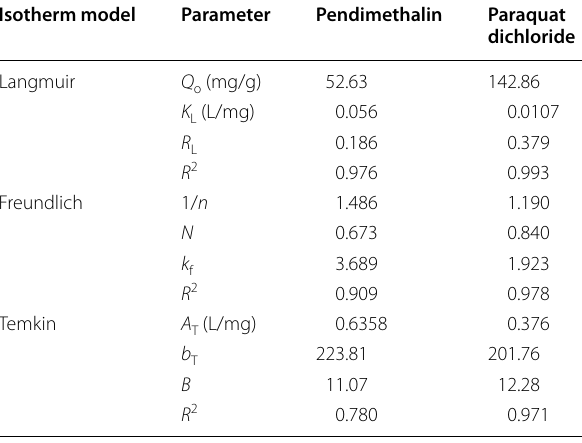
Table 1 Calculated Freundlich, Temkin and Langmuir Isotherm constants for the PQ and PE Adsorption onto ACBGNS Isotherm